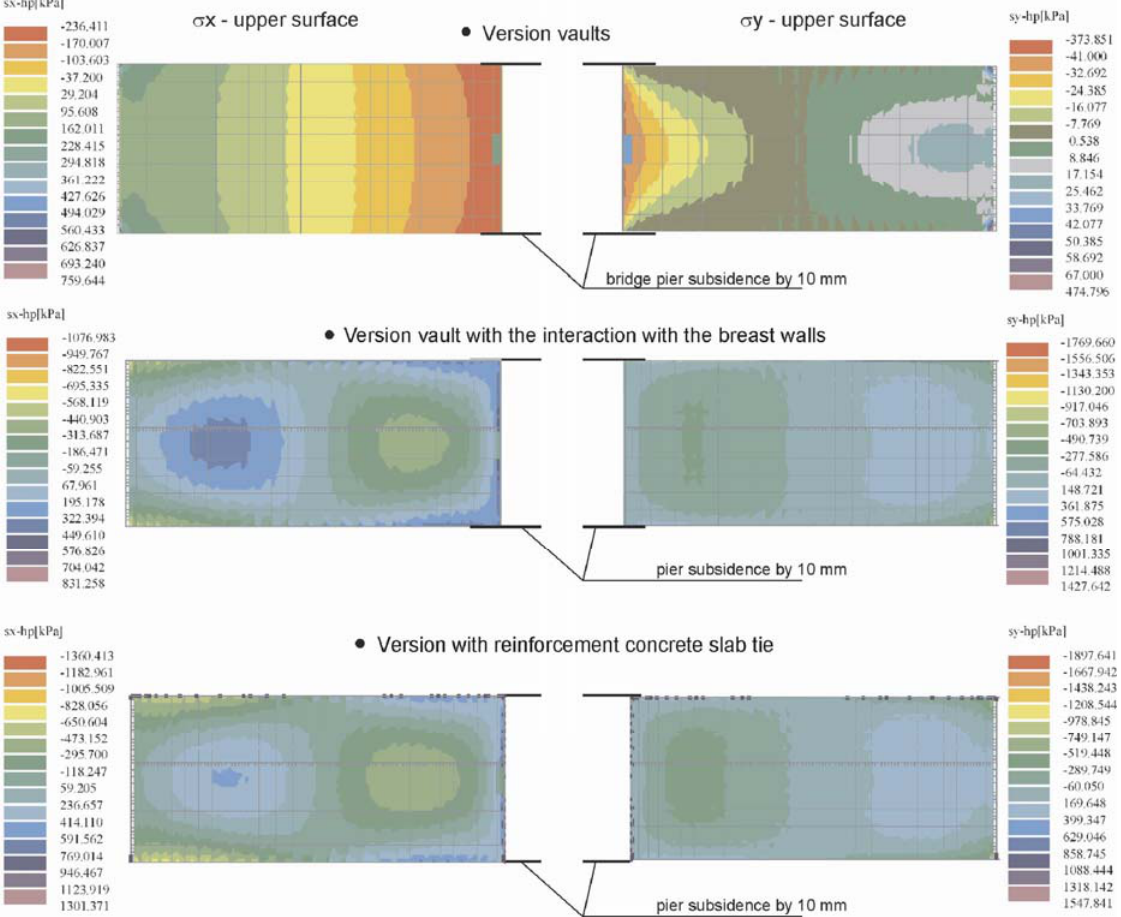
Fig 10. Field of normal stresses σ x (longitudinal) and σ y (transverse) in bridge vault at pier subsidence by 10 mm